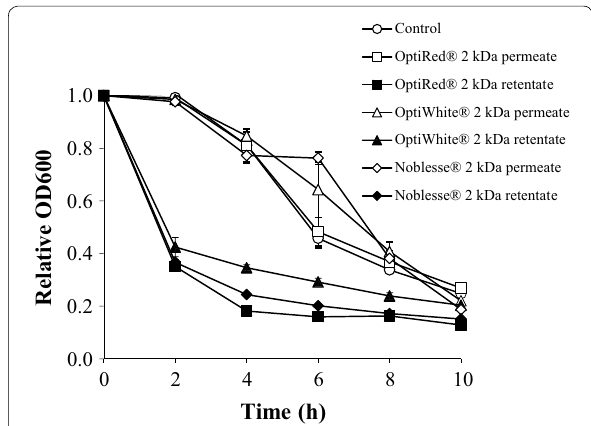
Fig. 4 Aggregation of L. rhamnosus HN001 with 2 kDa membrane permeates and retentates of IYD supernatants. Values are the mean of triplicate experiments ( n 3), with error bars representing the = standard deviations of the mean